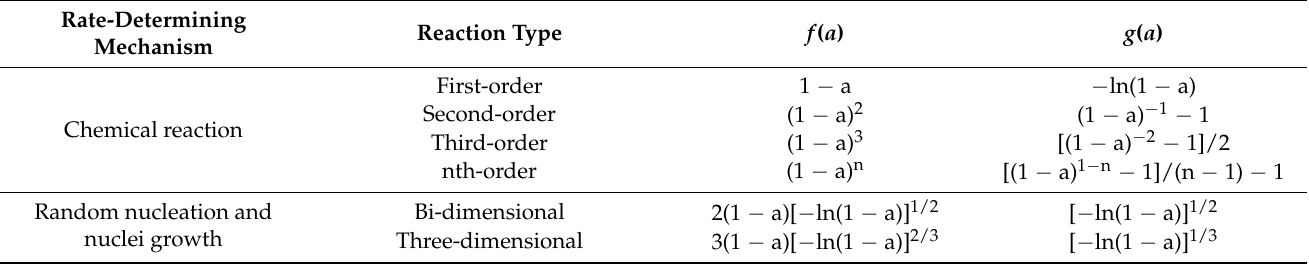
Table 1. Common pyrolysis reaction mechanisms for solid state reactions